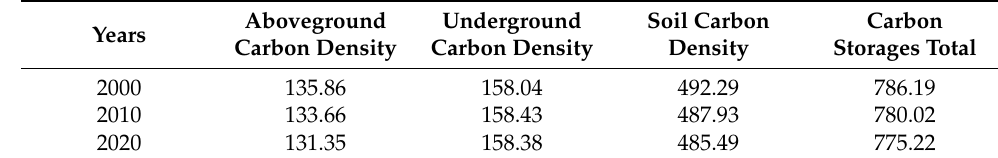
Table 2. Carbon stocks of various types in Zoig ê alpine grassland (Unit: Tg).